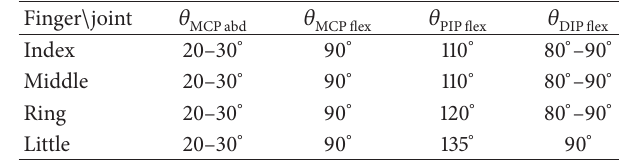
Table 2: Angles of active movements of the joints of the fingers: index to little finger.